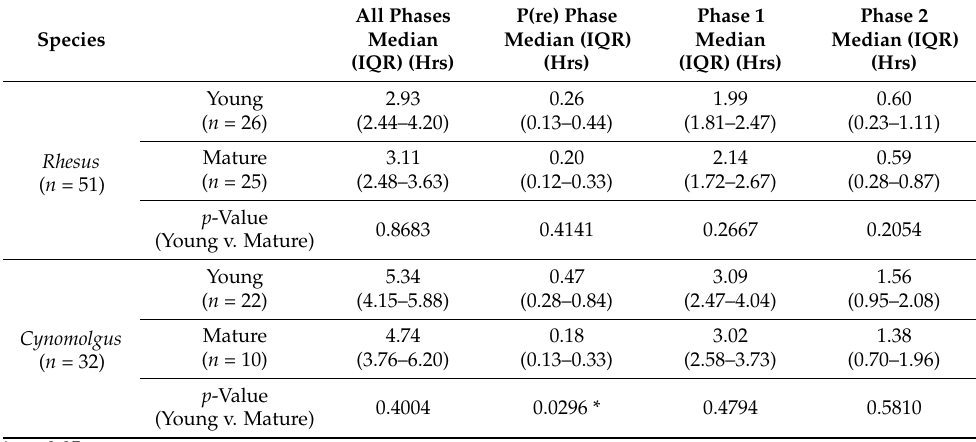
Table 6. Training Time Summary by